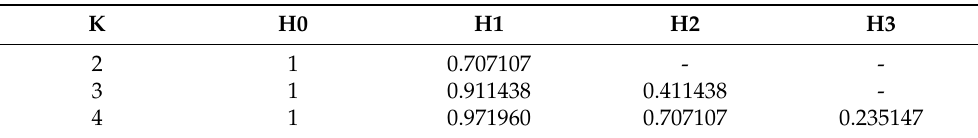
Table 1. PHYDYAS filter